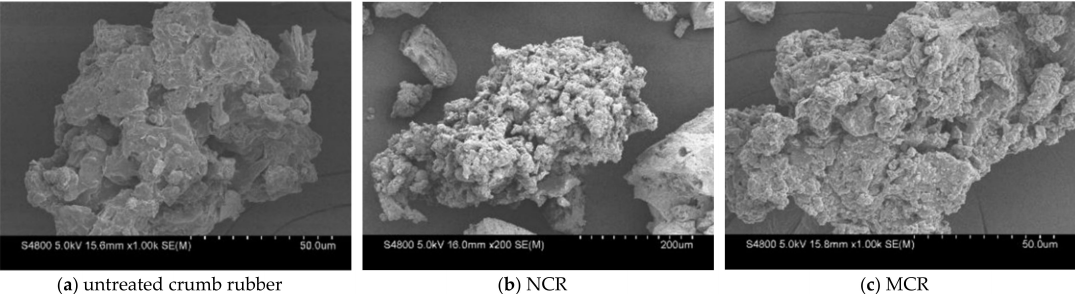
Figure 8. SEM micrographs of untreated crumb rubber, NCR, and